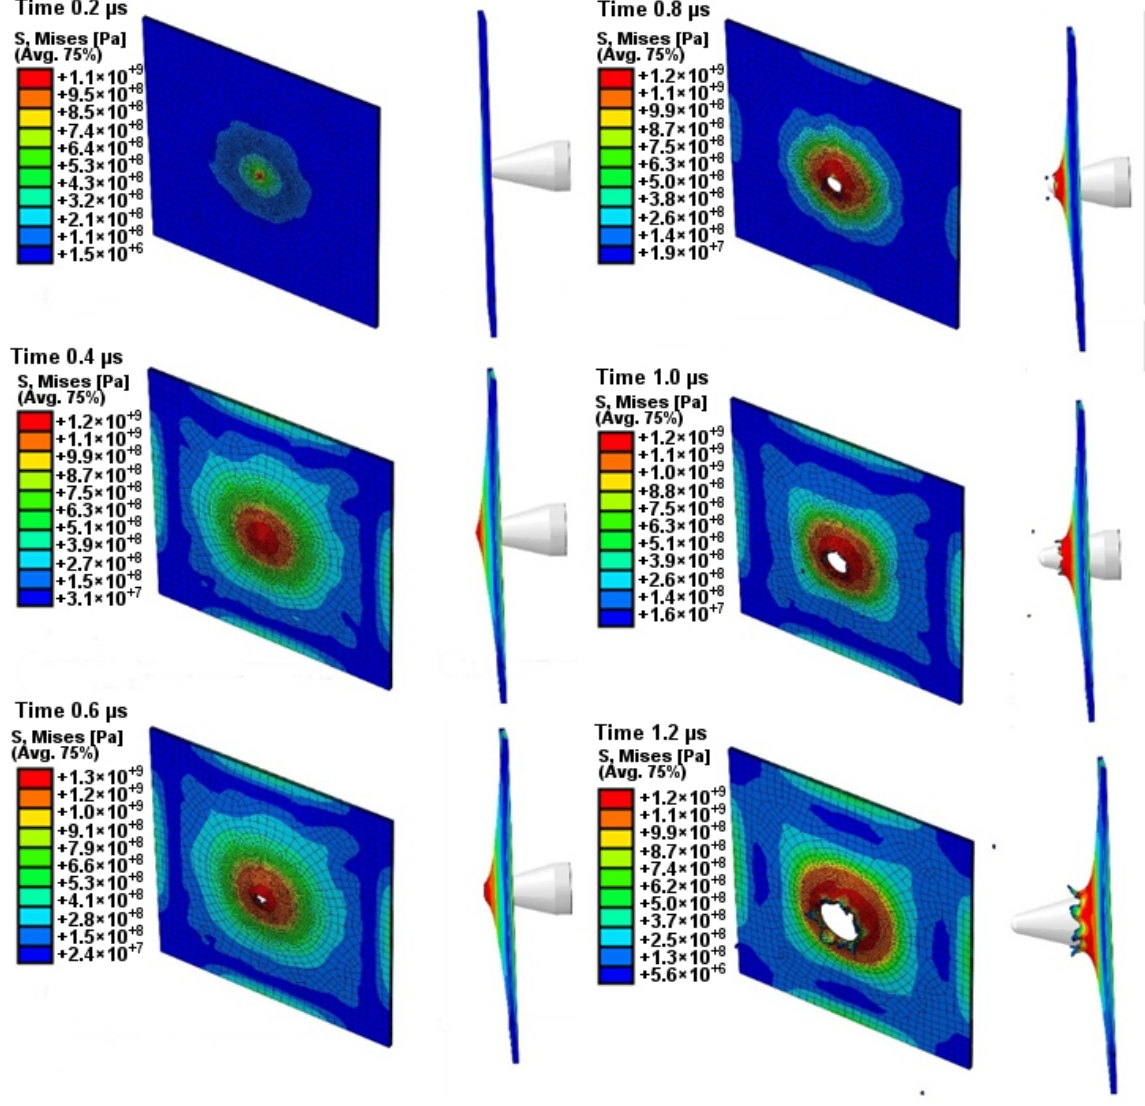
Figure 18. HMH stress visualization of one titanium alloy plate during the impact test. Material crumbling and the formation of characteristic flakes comparable to the ex- periment can be observed during damage propagation. The highest value of reduced stress (1.3 × 10 9 Pa) was recorded for a step of 0.6 µs. At this point, the material undergoes progressive decohesion. At the next step ( t = 0.8 µs), spring relief of the material can be observed by comparing the stress areas. At the time of decohesion, reduced stress greater than or equal to 2.8 × 10 8 Pa is present across the majority of the specimen area. However, in the next step ( t = 0.8 µs), the reduced stress importantly decreases over a significant area below the value of 1.4 × 10 8 Pa, only to increase again in the next simulation step ( t = 1.0 µs). This increase continues until the punch fully passes through the specimen. Figure 19 shows the strain visualization of equivalent plastic strain (PEEQ) during sheet metal puncturing. The maximum strain value was 0.532. This value is greater than that available in the literature [27]. In the ABAQUS simulation process, tests such as temperature increase, stress triaxi- ality, and force at failure initiation were carried out. Figure 20 shows the sheet metal tem- perature increase at the puncture area where the maximum increase from the initial tem- perature was 287.3 K. Taking into account the initial conditions (initial temperature 296.15 K) the sheet was heated to 583.45 K. Figure 21 shows the stress during the puncture of the specimen. Compressive stress occurred when there was tensile stress on the opposite side